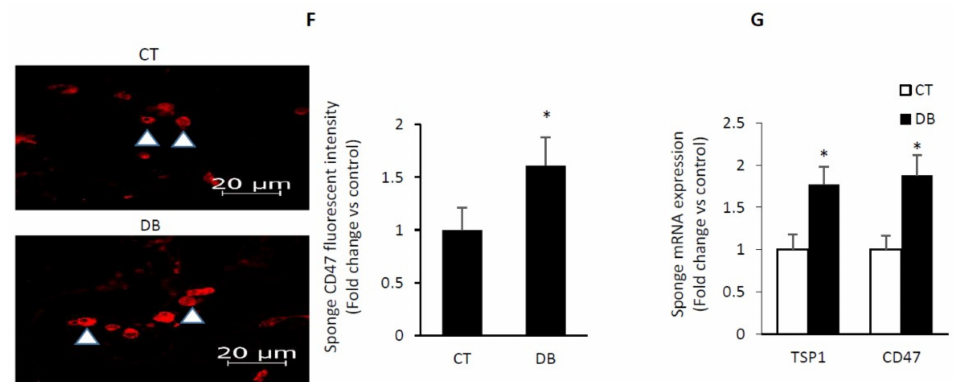
Figure 6. Diabetes up-regulates TSP1-CD47-dependent signaling in both W-ECs and in PVA sponge model of wound healing. ( A – C ) mRNA and protein levels of TSP1 and CD47 were assessed in control and diabetic W-ECs using qRT-PCR and Western blotting-based technique. ( D ) Rate of TSP1 production in cultured W-ECs was quantified using ELISA-based assay. Representative photomicrographs of TSP-1 ( E ) or CD47 ( F ) immunofluorescence staining, accompanied by a barograph figure denoting the quantitative measure of TSP-1 ( E ) or CD47 ( F ) fluorescence intensity. ( G ) mRNA expression of TSP-1 and CD47 in sponge model of wound healing was measured using qRT-PCR. Abbreviation: TSP1, thrombospondin-1 W-ECs, wound endothelial cells, CT, control; DB, diabetic. Values are means ± SEM ( n = 6) * Significantly different from corresponding control values at p ≤